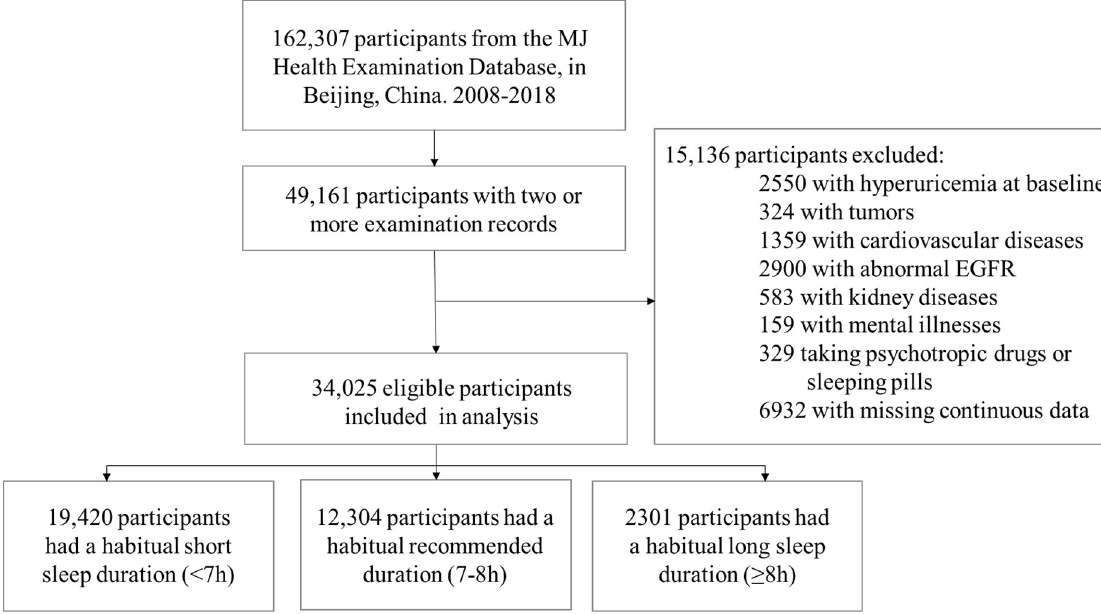
Figure 1. Flow chart for inclusion and exclusion criteria. EGFR indicates estimated glomerular filtration rate.